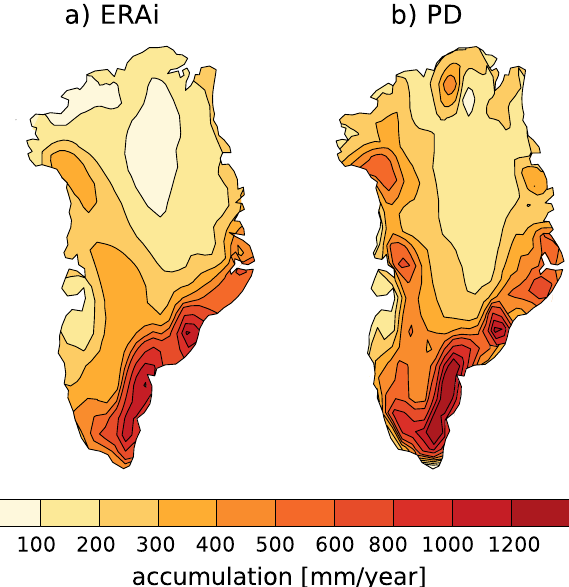
Fig. 3. Annual mean accumulation [mmyr − 1 ] over the Greenland Ice Sheet for (a) ERAi and (b) PD